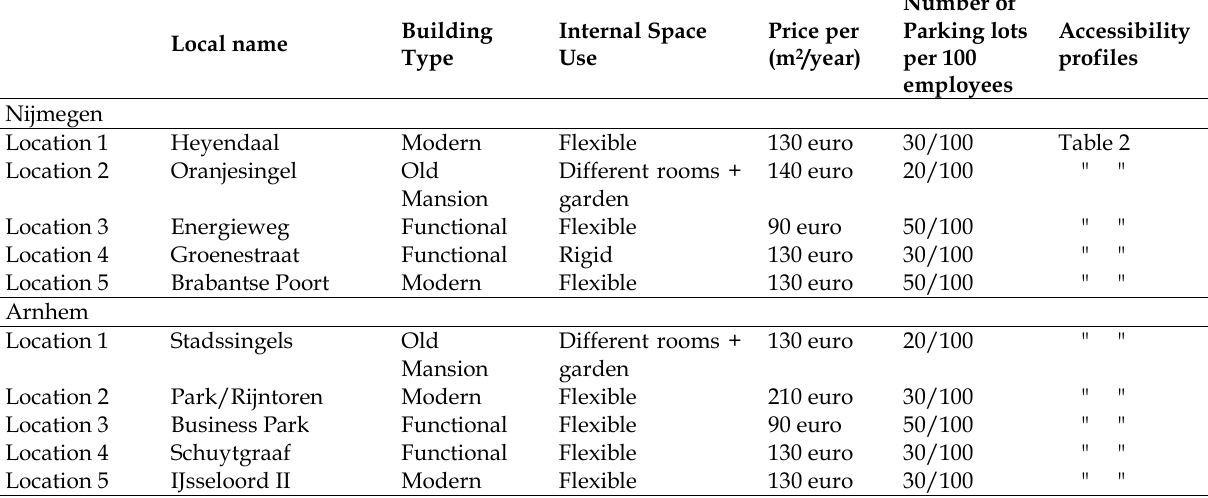
Table 3. Selected office locations in Arnhem and Nijmegen described in